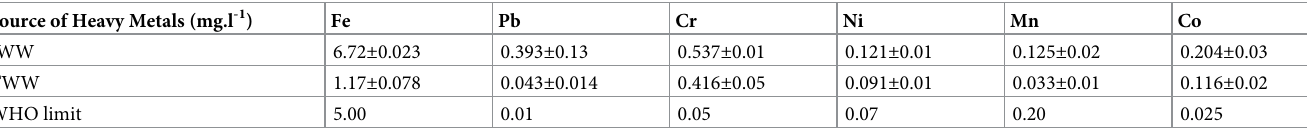
Table 2. Concentrations of heavy metals in IWW and TWW in comparison with WHO limits [26, 40, 41]. Source of Heavy Metals (mg.l -1